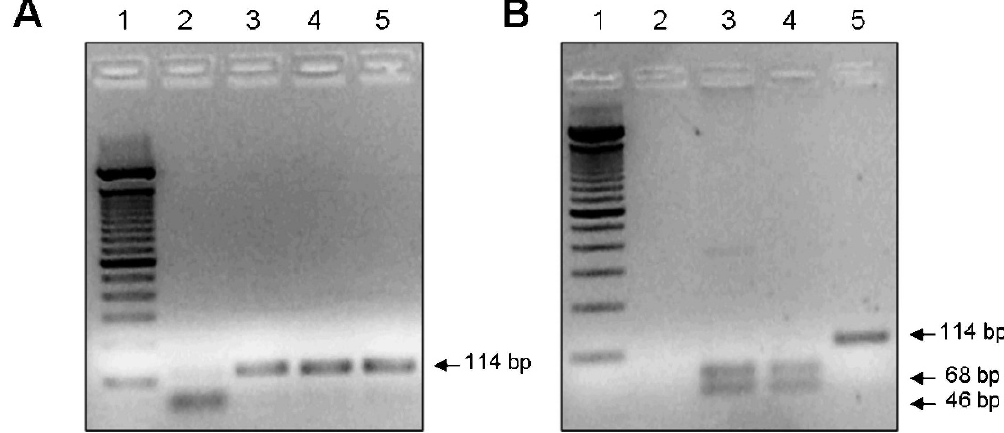
Figure 4 - FLT3 -D835 genotyping. (A) PCR amplification of FLT3 : lane 1: 100 bp ladder; lane 2: negative control; lanes 4 to 5: 114-bp amplicons obtained from the genomic DNA of patients with MDS (3-4) and AML (5). (B) Eco321 digestion: lane 1: 100 bp ladder, lane 2: negative control; lanes 3 and 4: digestion pattern observed in two MDS patients negative for the FLT3 -D835 allele, lane 5: digestion pattern observed in an AML patient with the FLT3- D835